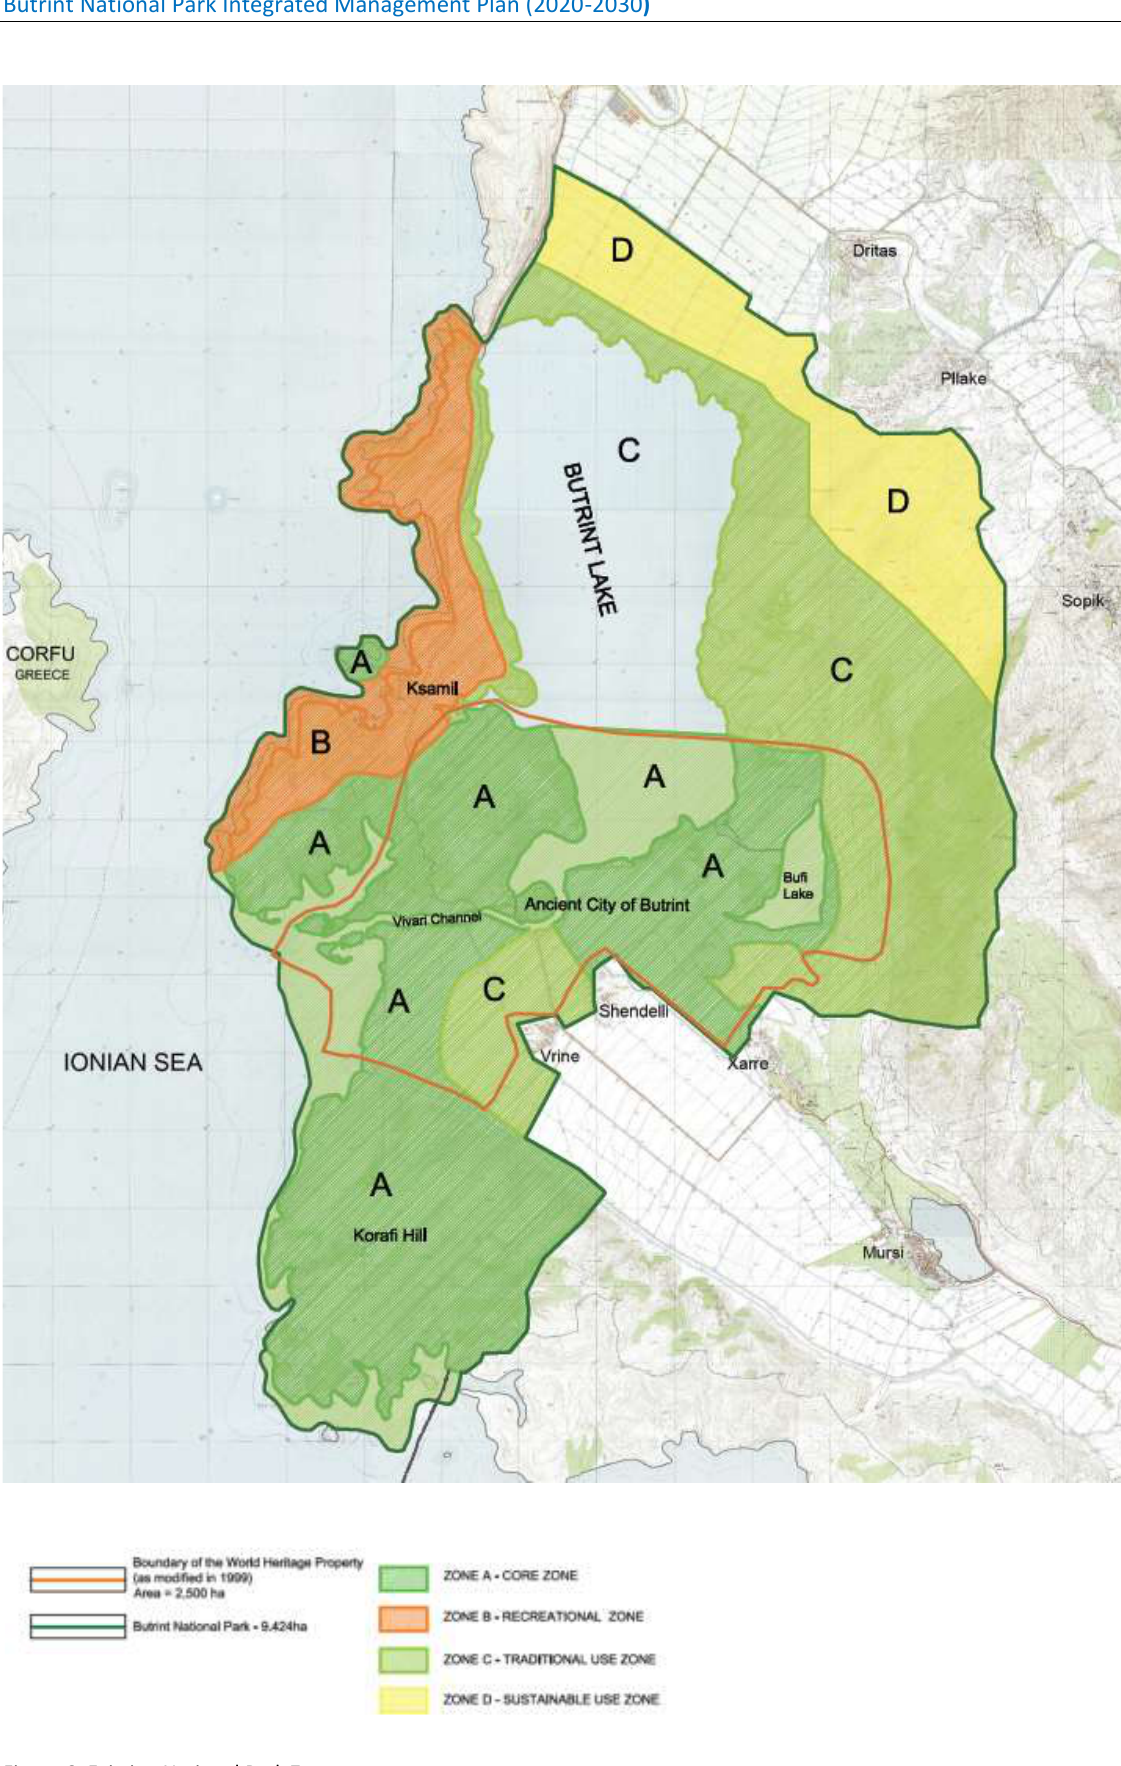
Figure 6: Existing National Park